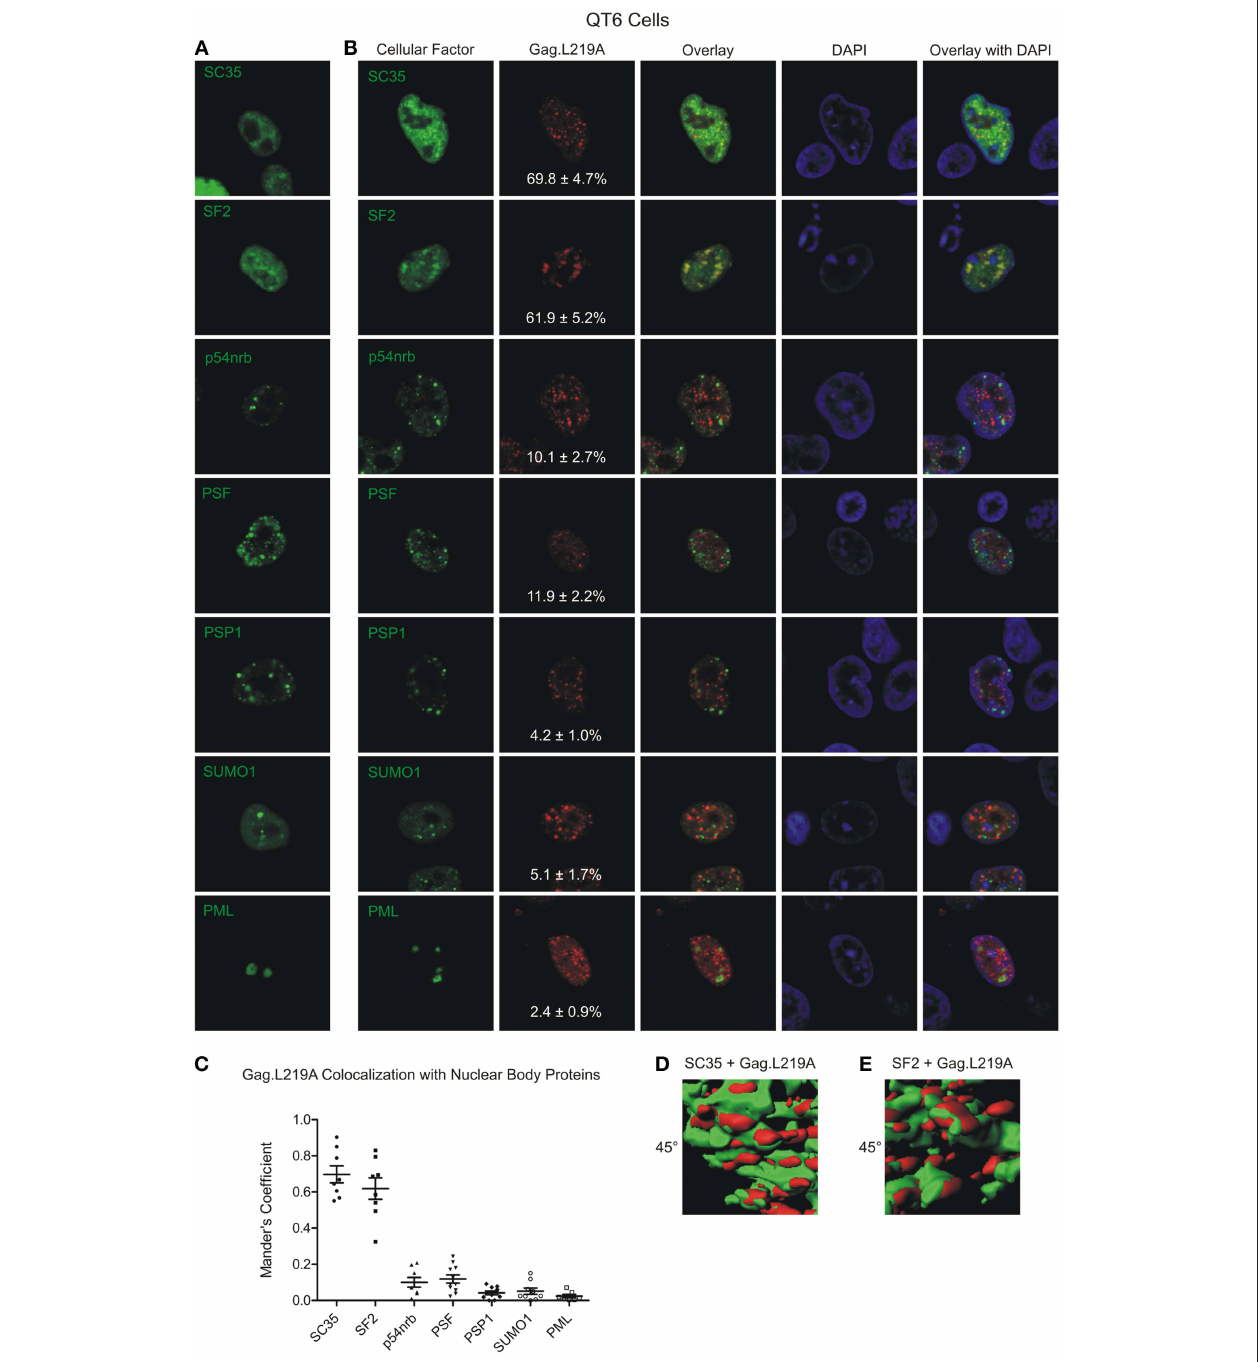
FIGURE 2 | Localization of Gag.L219A with host nuclear body proteins in QT6 cells. (A) Localization of Gag.L219A and nuclear body proteins in singly transfected QT6 cells. (B) Co-localization analysis between Gag.L219A and the indicated nuclear body proteins in co-transfected QT6 cells. Merging of Gag.L219A and nuclear body marker protein channels is displayed (Overlay). The DAPI channel is also depicted. The percentage of Gag.L219A with each factor is depicted in the Gag.L219A channel with the standard error of the mean. (C) Scatterplot depicting the mean and standard error of the mean of Gag.L219A co-localization with each of the nuclear body protein. (D) Still image from Supplemental Video 1 that closely examines a surface rendering of SC35 (green) and Gag.L219A (red). (E) Still image from Supplemental Video 2 that closely examines a surface rendering of SF2 (green) and Gag.L219A